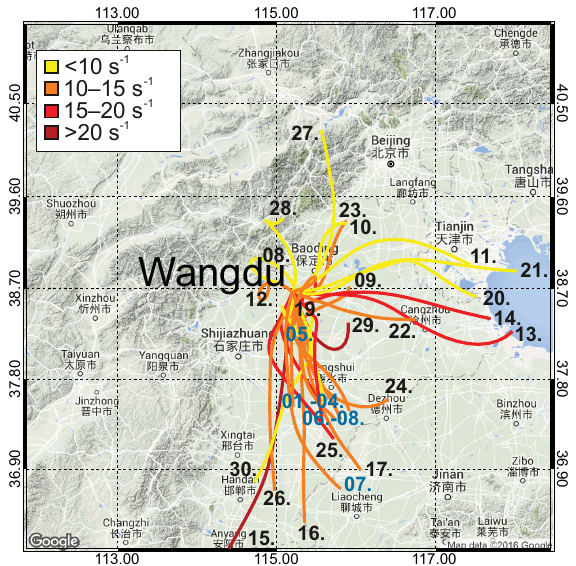
Figure 4. NOAA HYSPLIT 24h back-trajectories during the cam- paign calculated as averages of hourly back-trajectories between 10:00 and 19:00 local time. Colors of trajectories indicate the OH reactivity level measured at the field site in Wangdu. Black numbers indicate the date in June, dark blue numbers the date in